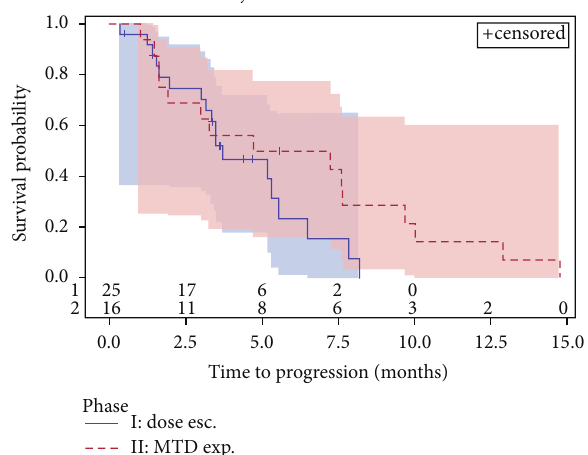
Figure 2: Time to progression for phase I and phase II.